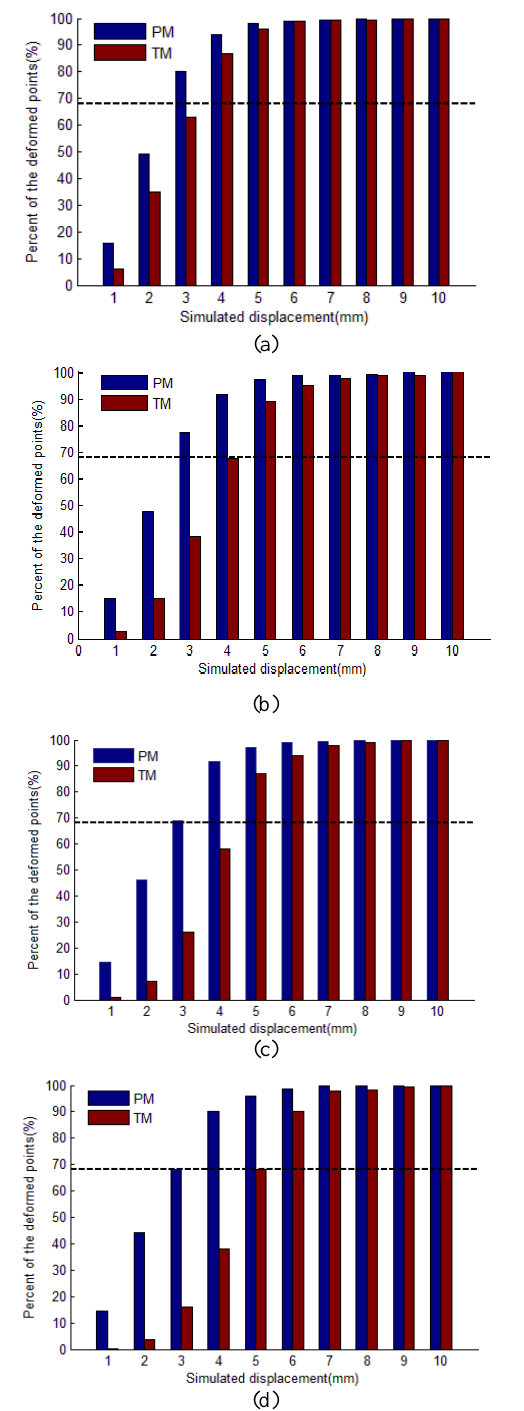
Fig. 10 Results of the PDOP of each data point cloud with the varying scanning distance: (a) distance=20m; (b) distance=40m; (c) distance=60m; (d) distance=80m. The black dotted line shows the threshold value of the PDOP where the displacement could be detected.